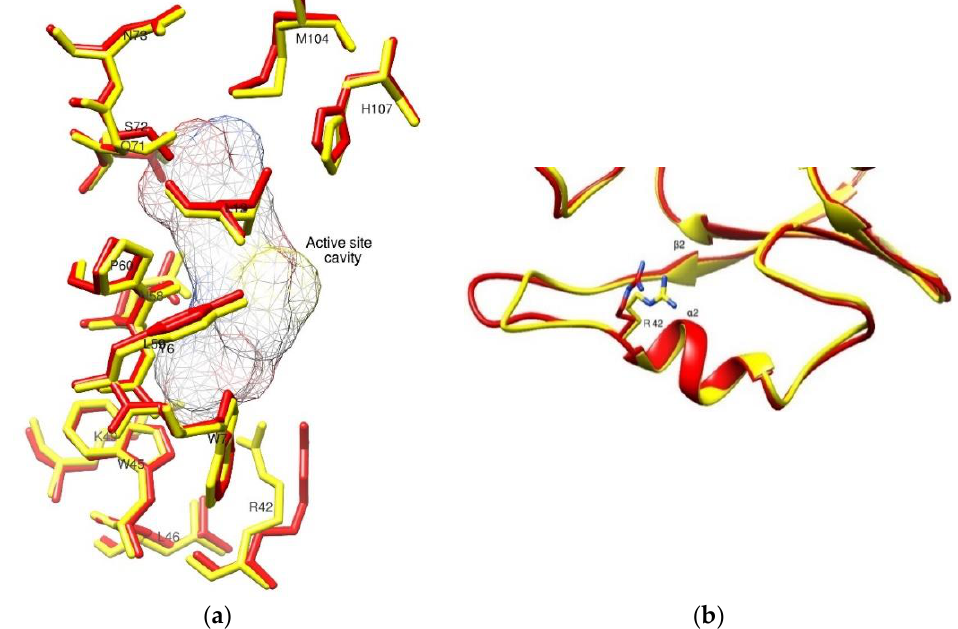
Figure 5. ( a ): Superposition of the active site residues of high-resolution (1.59 Å ) structure of human GSTM1-1 (colored yellow) and low-resolution (2.68 Å ) structure of HGSTM1-1 (colored red) (PDB id 1gtu). The active site location is denoted by a mesh surface created for GSH. ( b ): Close-up view of the loop region connecting β2 strand and α2 helix.